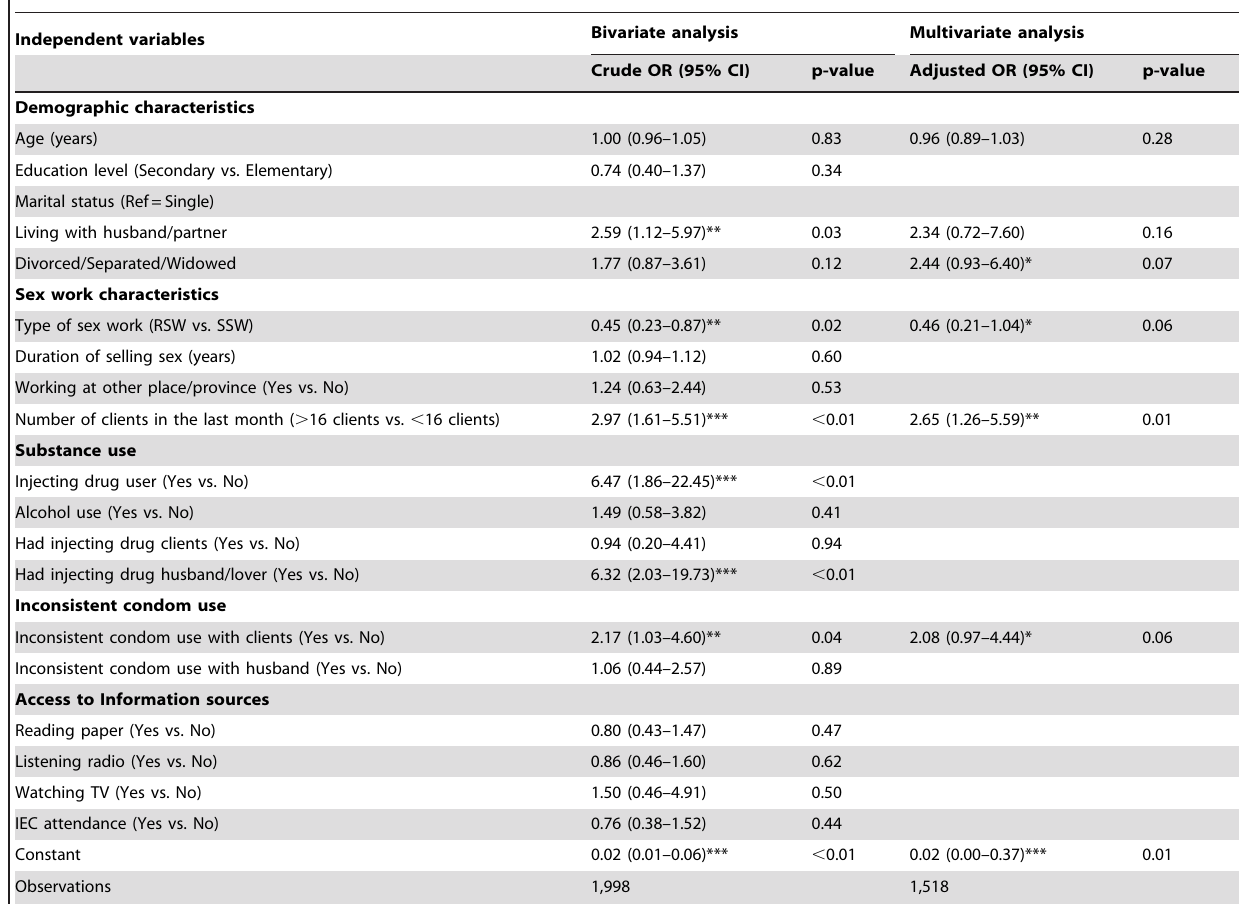
Table 3. Correlates with HIV infection among female sex